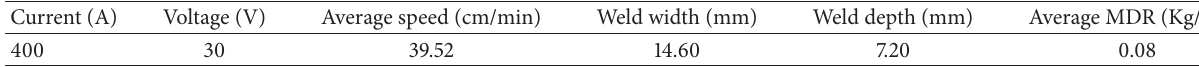
Table 1: Experimental data.